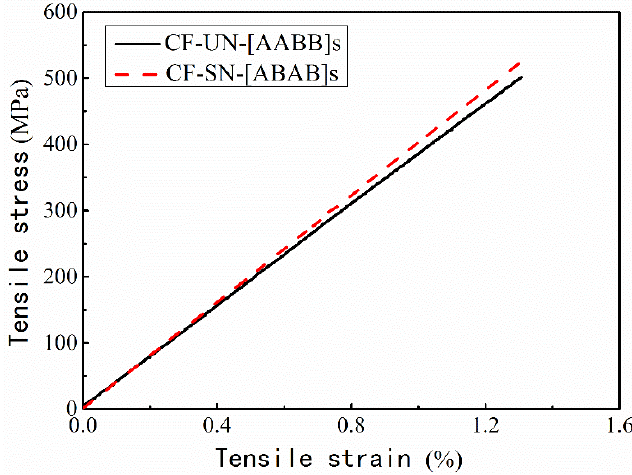
Figure 9. Comparison of the stress–strain relations of specimens with different layer sequences. The curves are almost the same, but the stress concentration at the crack tip of specimen CF ‐ SN ‐ [ABAB]s is more evident than that of specimen CF ‐ SN ‐ [AABB]s.